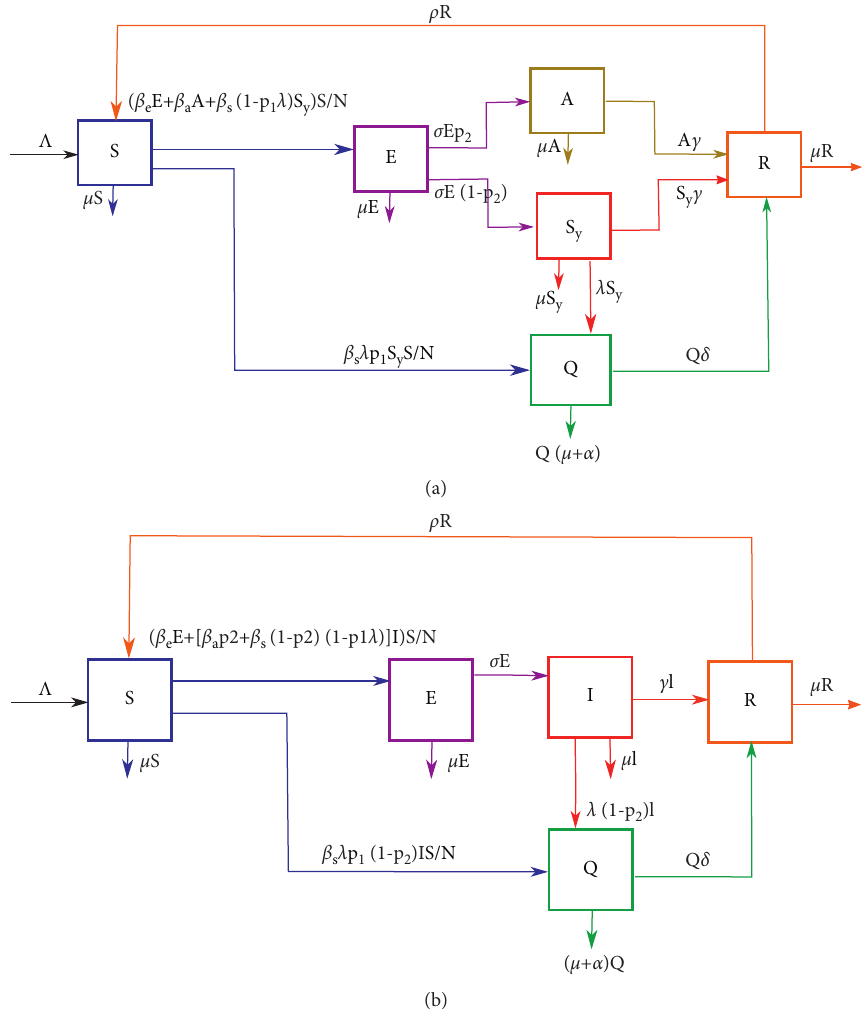
Figure 1: (a) Flow chart of the epidemic model and (b) reduced flow chart of the epidemic